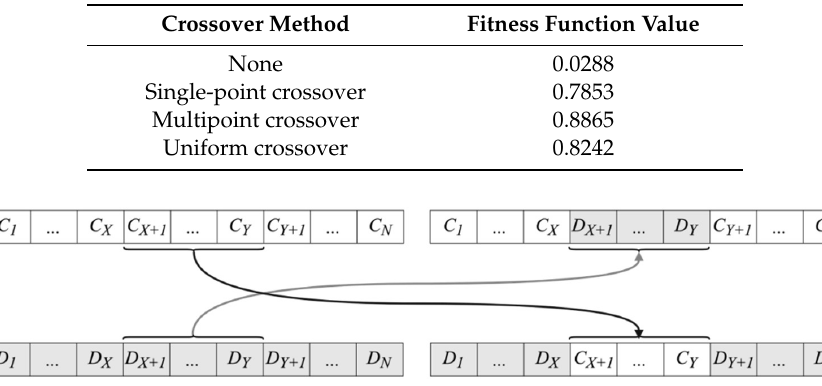
Table 4. Optimization results for different crossover methods.